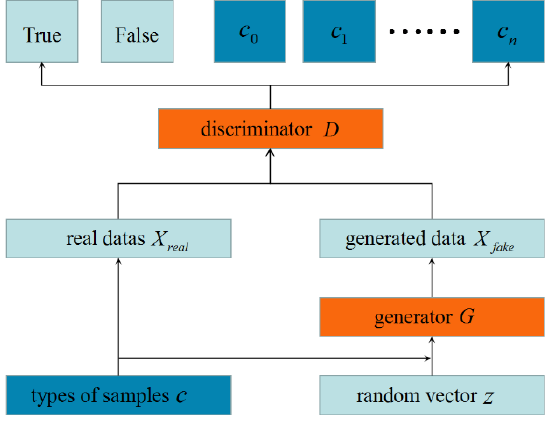
Figure 1. Main Structure of ACGAN.